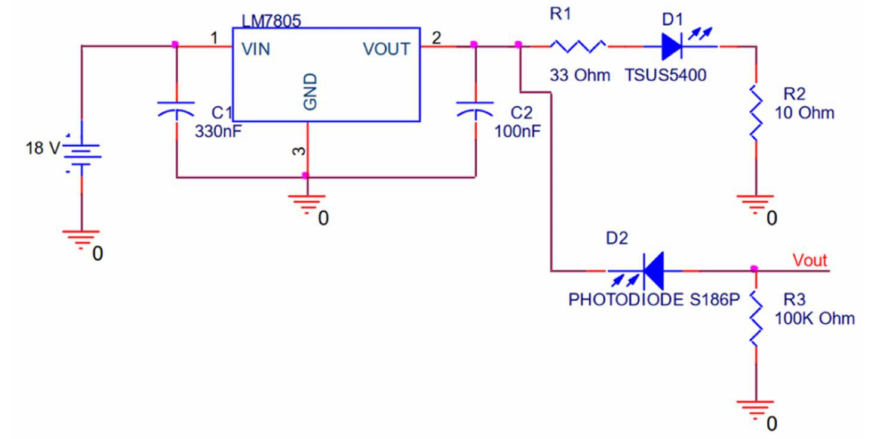
Figure 2. The electronic circuit of the turbidity sensor.